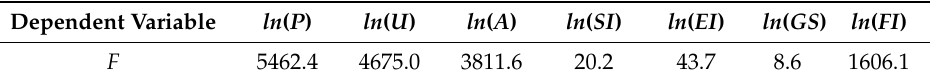
Table 2. F test values for each independent